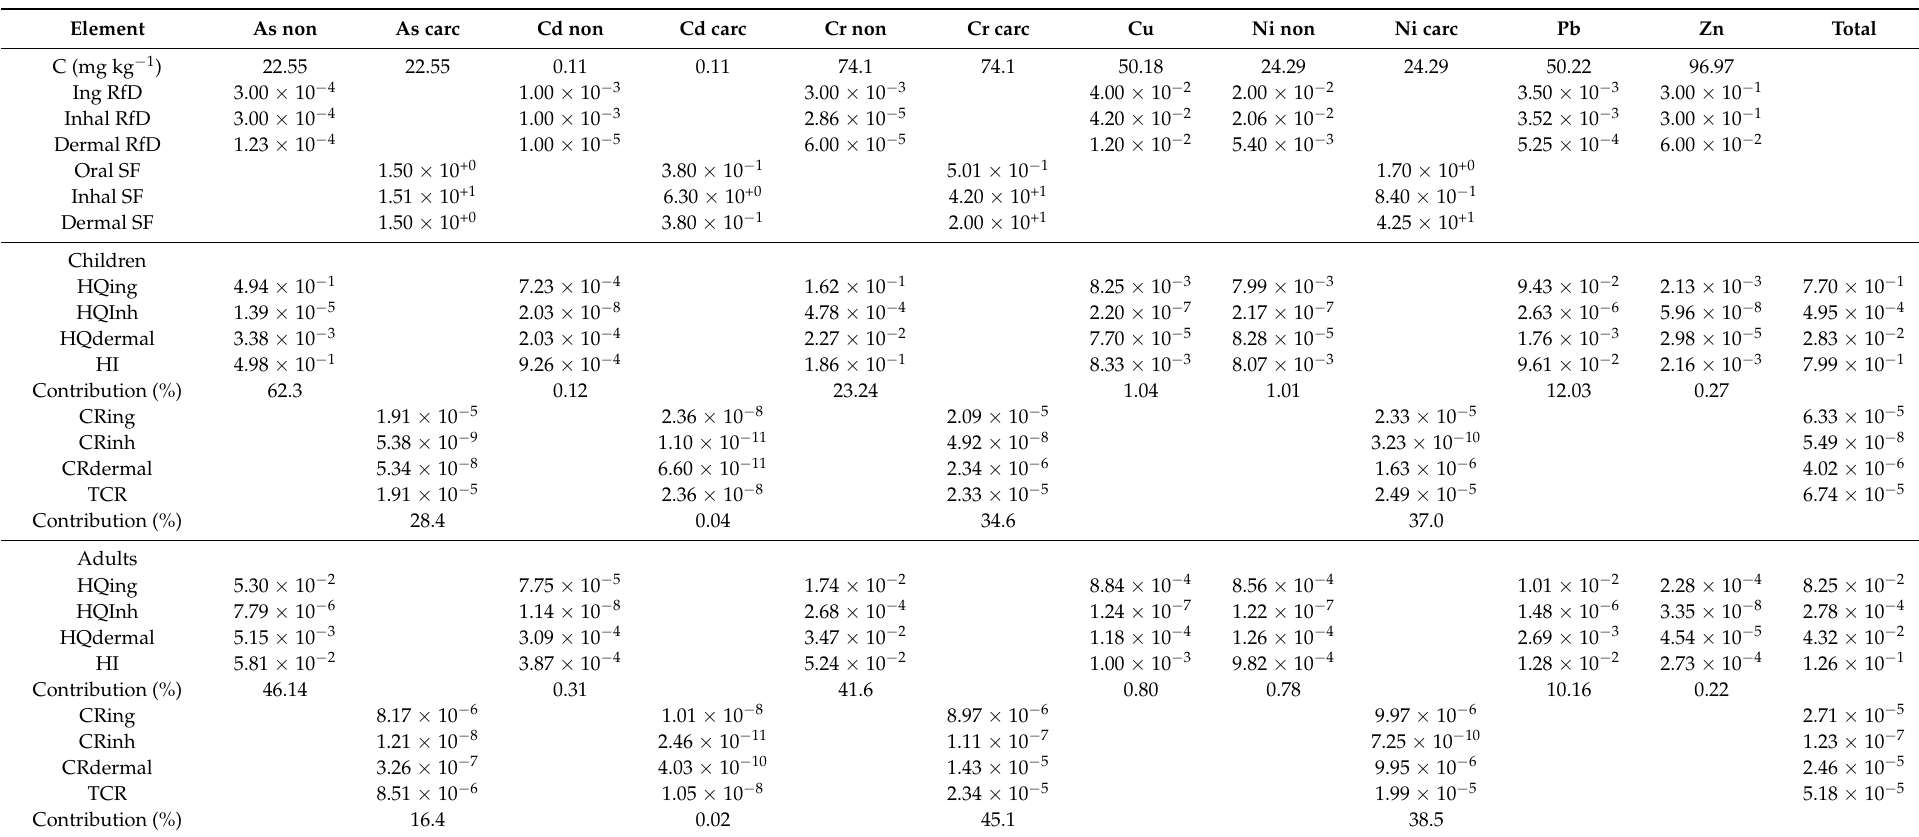
Table 5. Non-carcinogenic and carcinogenic risks via ingestion, inhalation, and dermal contact of As, Cd, Cr, Cu, Ni, Pb, and Zn, in children and adults in the soils that surround S ã o Pedro da Cova mine waste